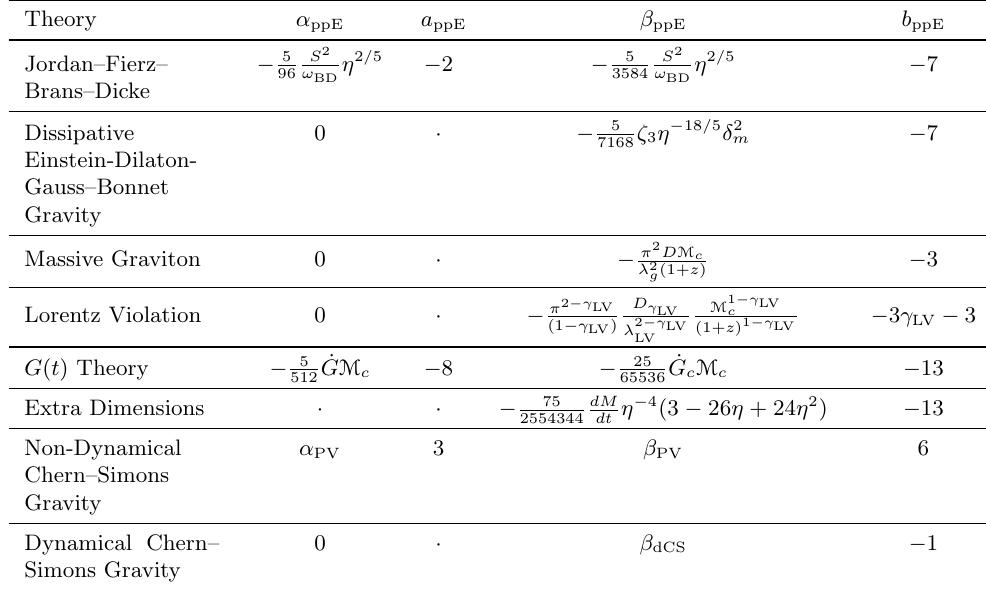
Table 3: Parameters that define the deformation of the response function in a variety of modified gravity theories. The notation · means that a value for this parameter is irrelevant, as its amplitude is zero. Theory 𝛼 ppE 𝑎 ppE 𝛽 ppE 𝑏